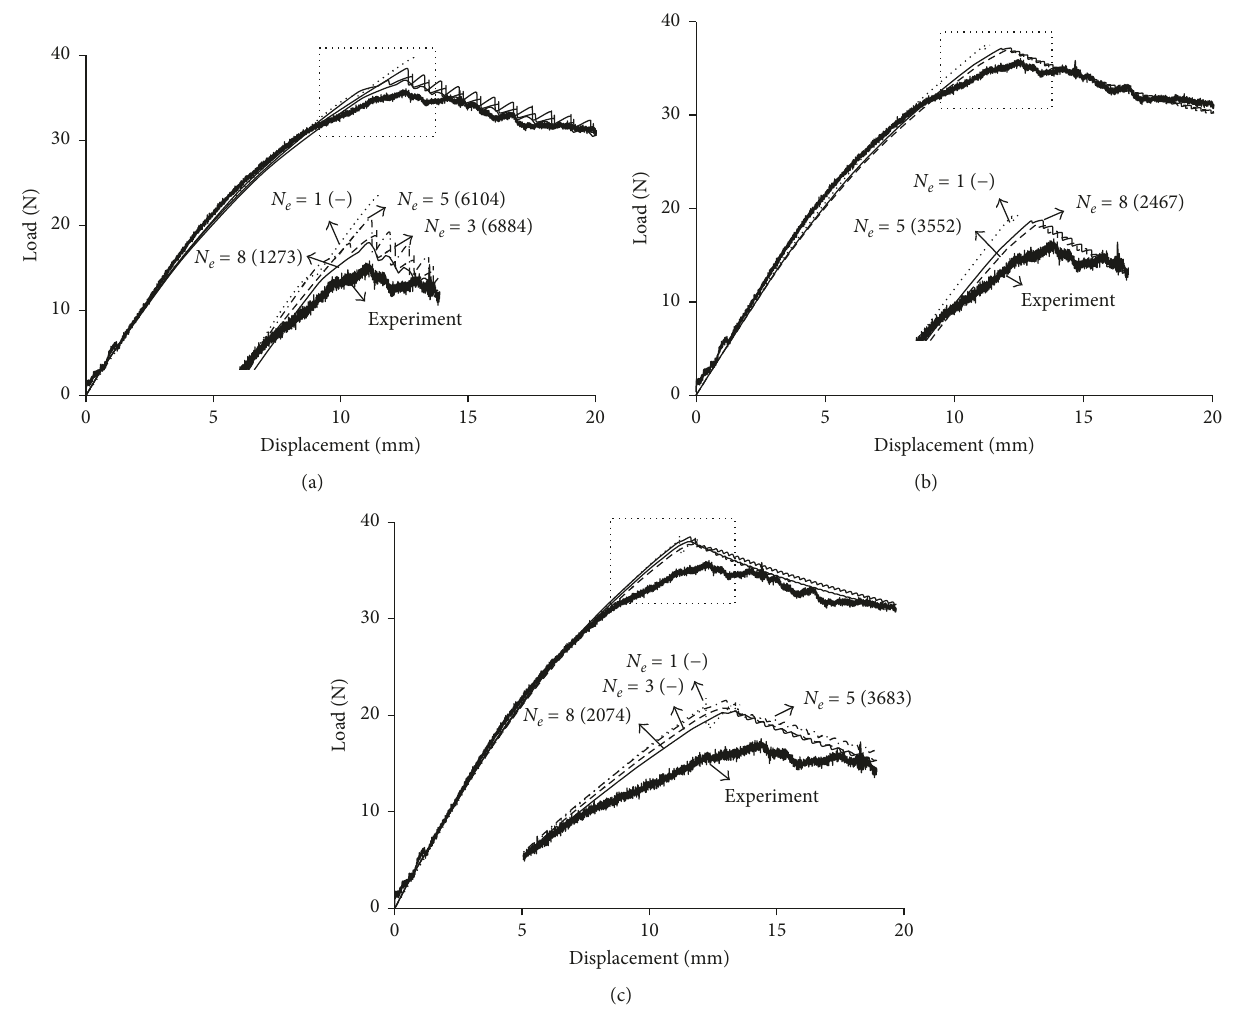
Figure 7: Load-displacement curve of C-C configuration for different cohesive element sizes: (a) l (c) l e (cid:31)